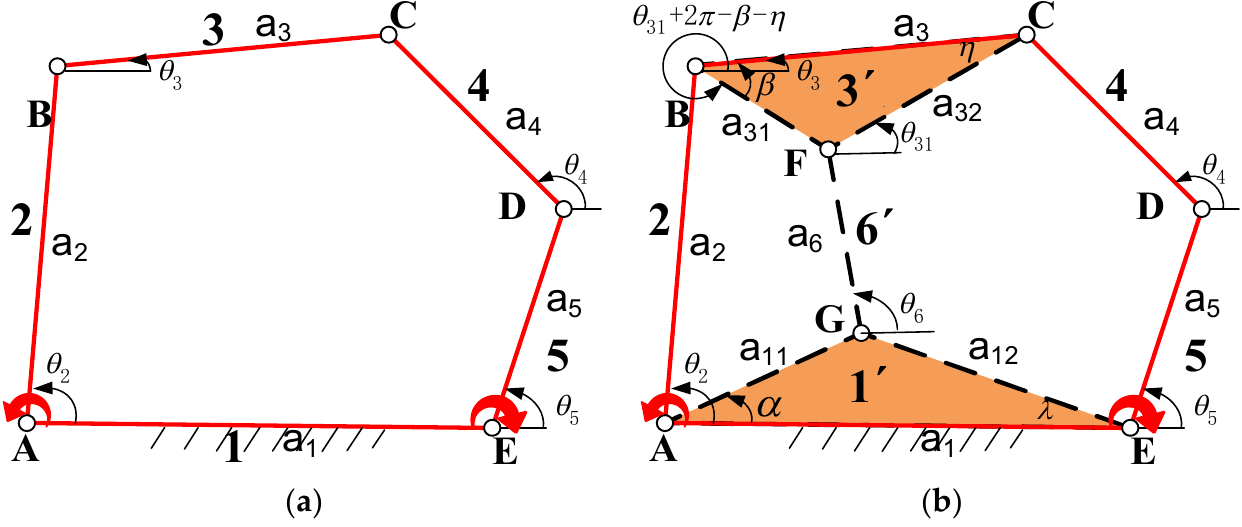
Figure 7. ( a ) Single-loop two-DOF five-bar planar linkage, ( b ) Two-loop virtual Stephenson planar linkage. Mathematical proof for single-loop five-bar planar